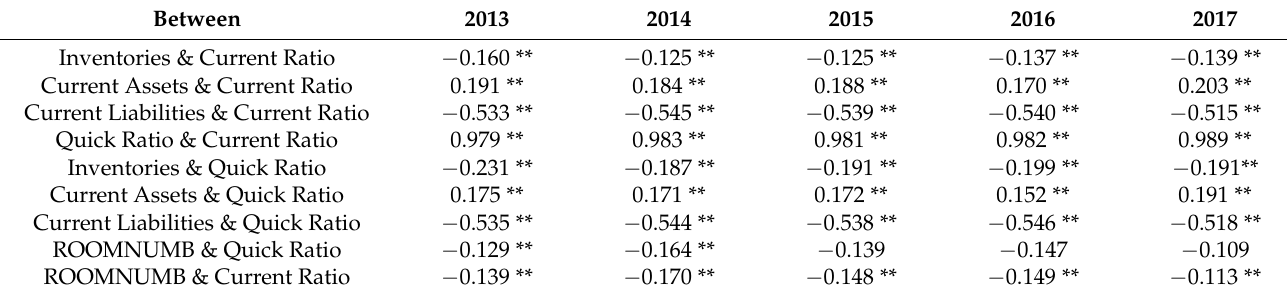
Table 8. Results of Spearman (cid:48) s Rho test to verify the relation between variables. Between